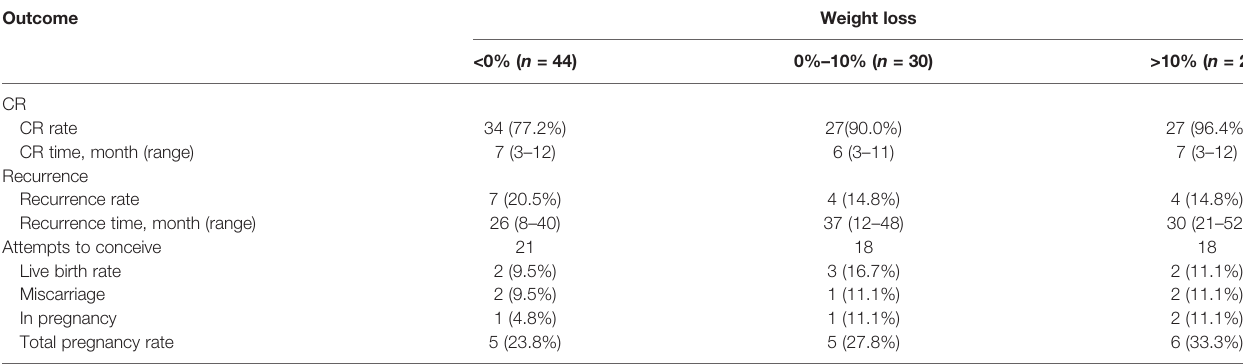
TABLE 4 | Correlation between body weight change and treatment outcomes.